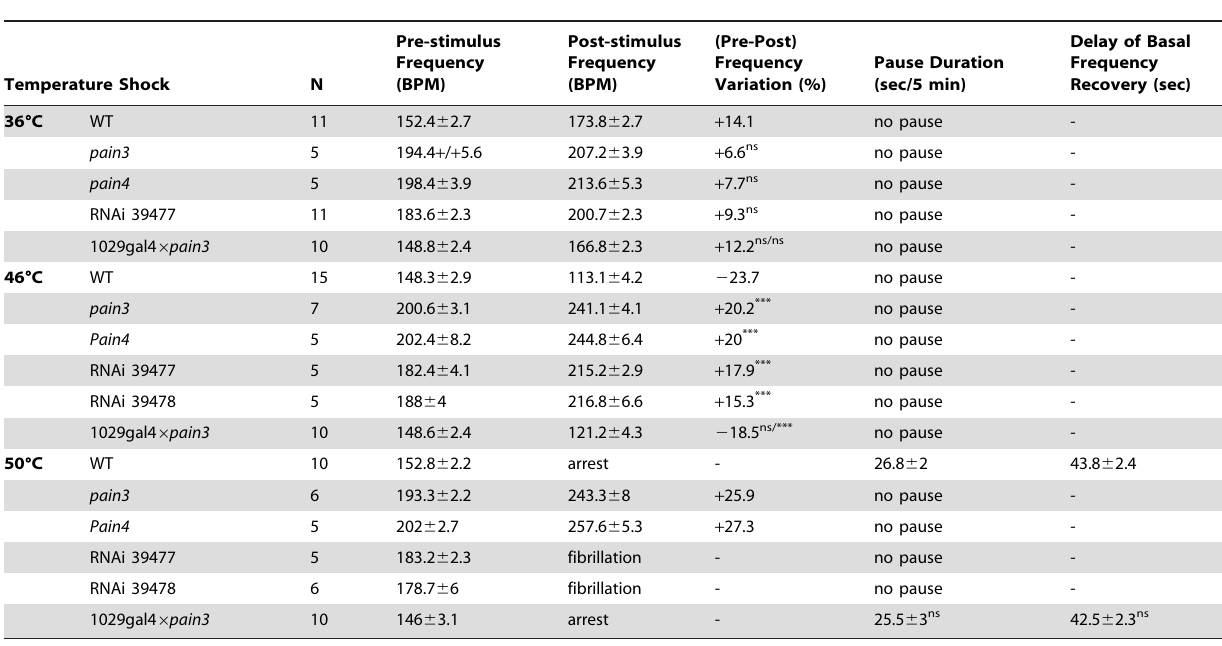
Table 2. Averaged characteristics of cardiac defects following temperature shock.